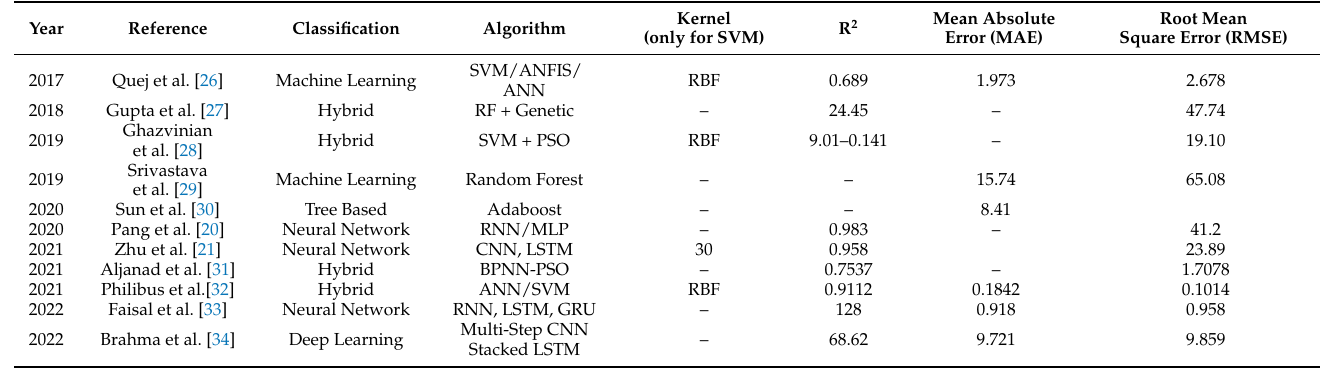
Table 1. Research papers with metrics used with most common machine learning